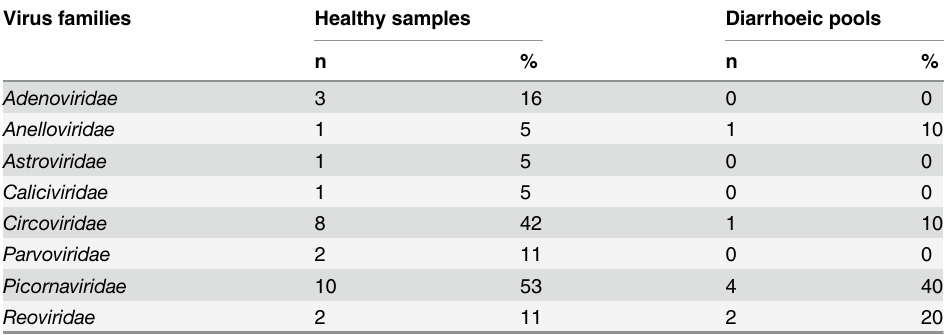
Table 4. Number of samples from healthy piglets (n = 19) and pooled diarrhoeic samples (n = 10) posi- tive for virus families known to infect